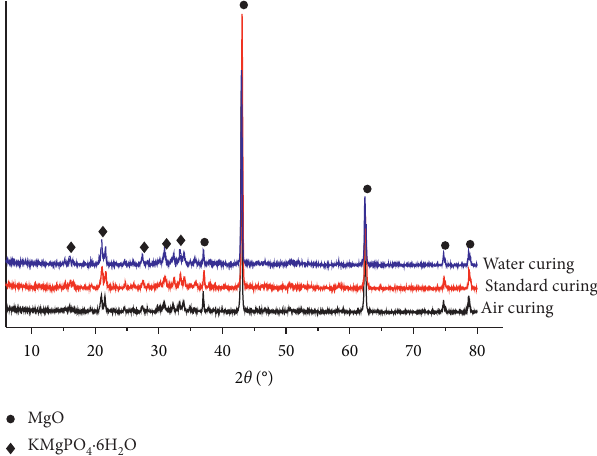
Figure 9: XRD patterns of the samples with the M / P mass ratio of 3:1 cured under various curing conditions for 28d.